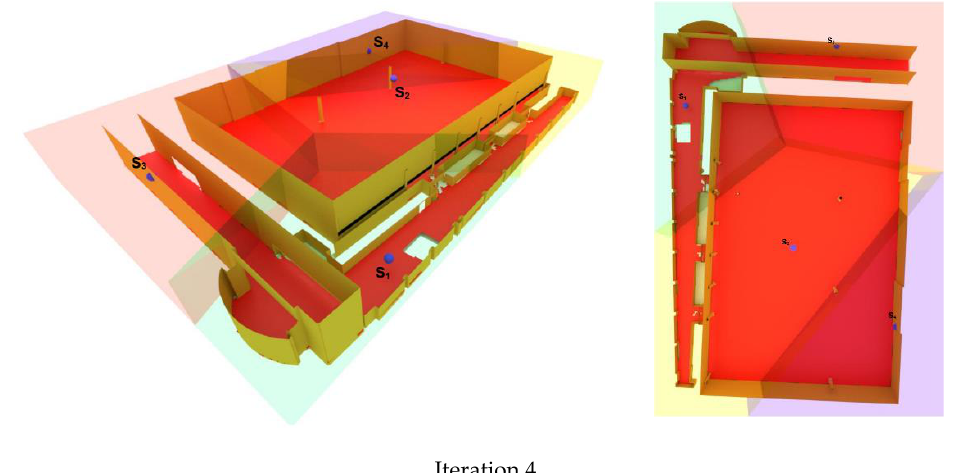
Figure 10. The result of the proposed 3D Voronoi approach including the positions of sensors (blue points), and their coverage (red area) for the first four iterations.